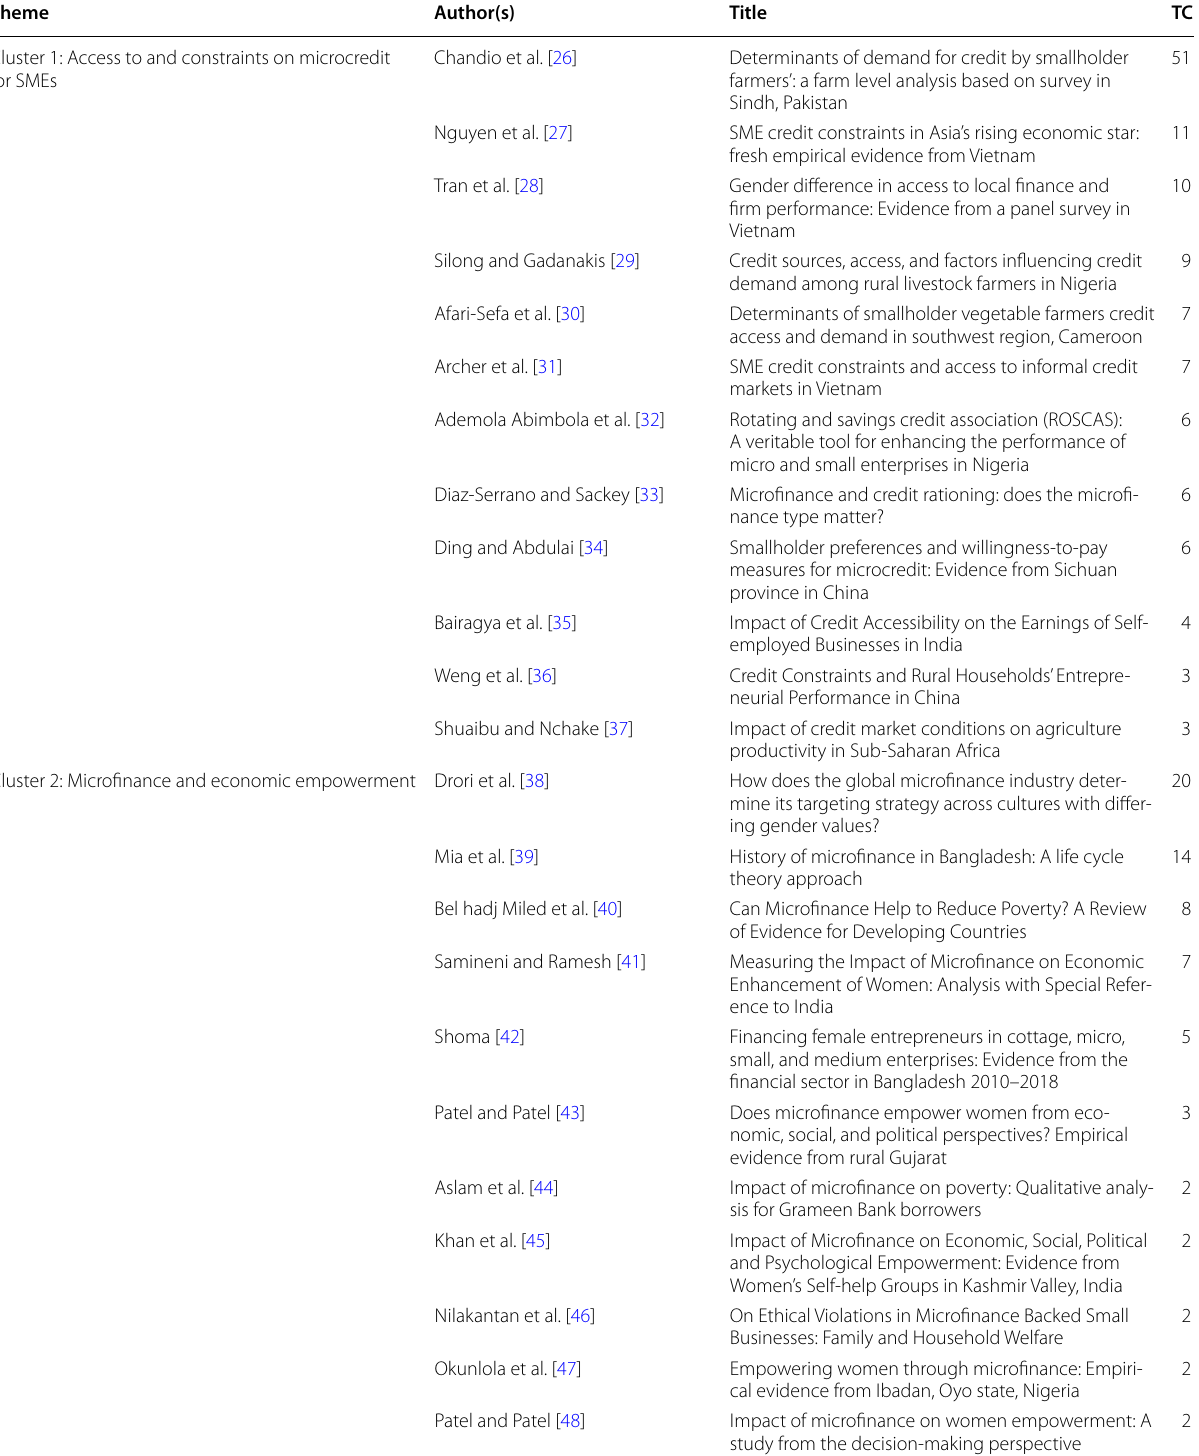
Table 5 Thematic clusters of microfinance and microfinance institutions research